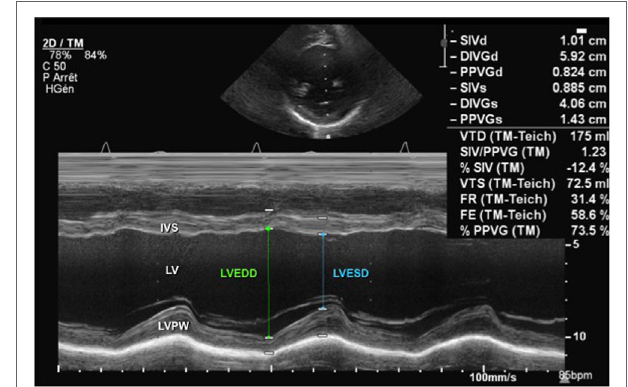
FigURe 1 | M-mode echocardiography from a parasternal short-axis view showing the left ventricular cavity over the cardiac cycle (see ECG tracing) during systole and diastole. Abbreviations: IVS, interventricular septum; LV, left ventricle; LVEDD, left ventricle end-diastolic dimension; LVESD, left ventricle end-systolic dimension; LVPW, left ventricle posterior